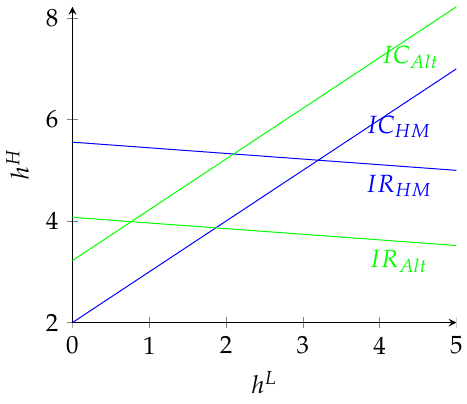
Figure A2. Optimal contracts for p 2